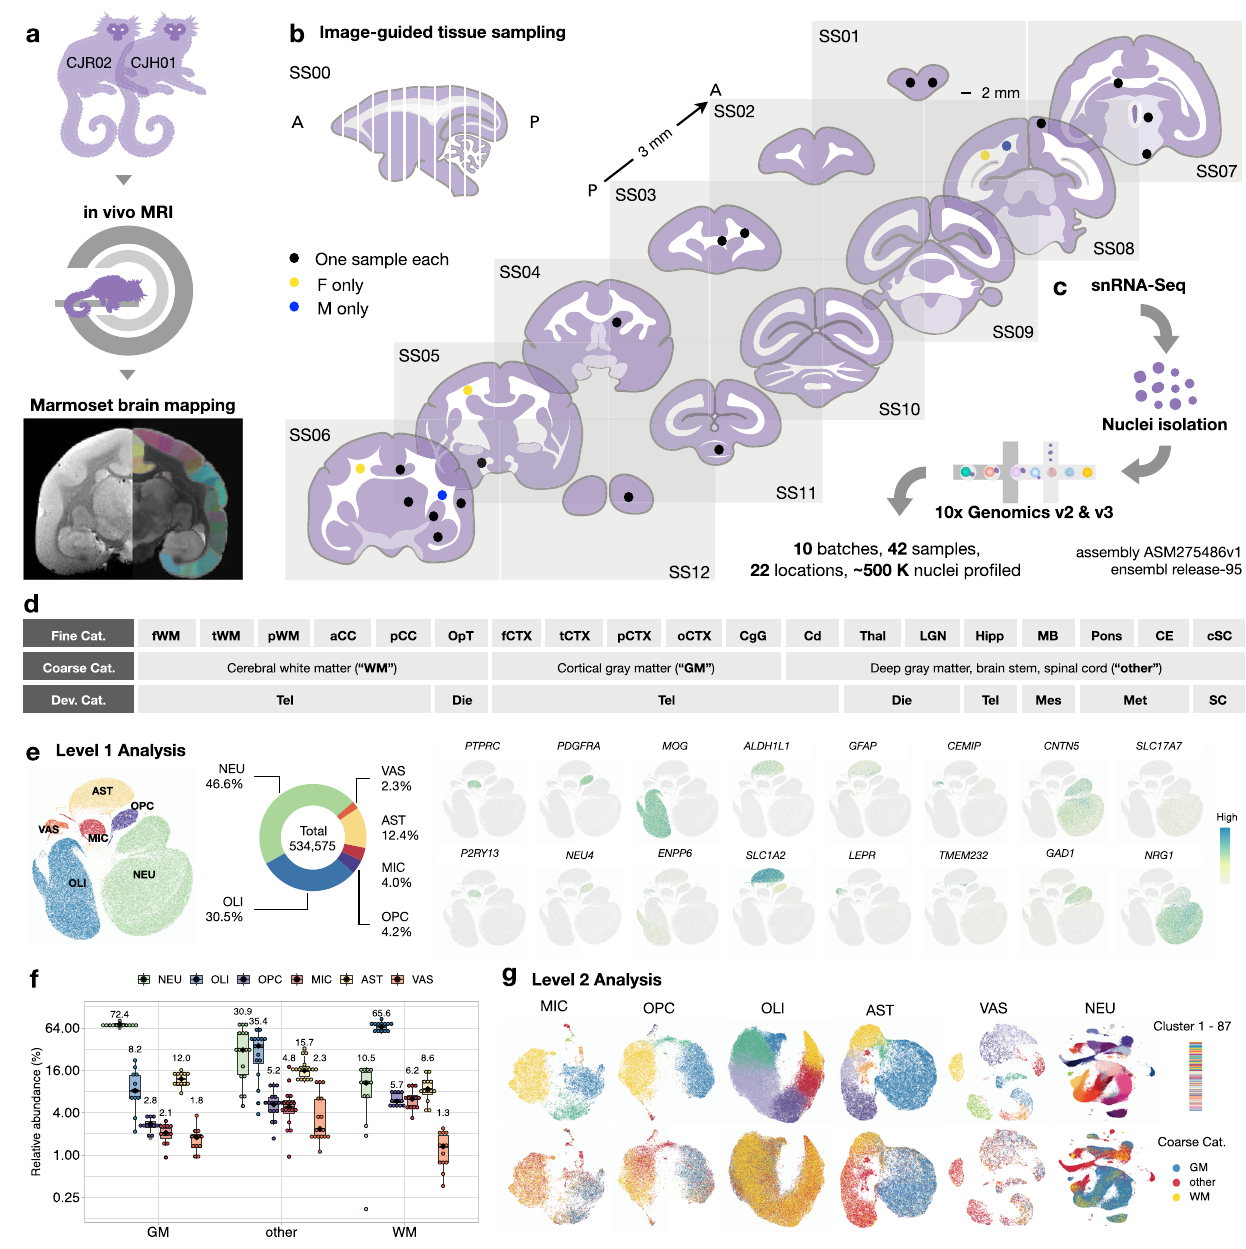
Fig. 1 | Glial transcriptome re fl ects differential residence in gray and white matter.a Experimentalwork fl owtoscanandmapimagestomarmosetMRIatlases. b Locationof samplescollectedascylindersof2mmdiameterand3mmthickness on the standard slab (SS) index. A anterior, P posterior. c Nuclei were isolated to prepare cDNA libraries and sequenced. d Total sampled areas are labeled by three types of tissue categories (Cat.): fi ne, coarse, and developmental (Dev). f frontal, t temporal,pparietal,WMwhitematter,aanterior,pposterior,CCcorpuscallosum, OpT optic tract, CTX cortex, o occipital, CgG cingulate gyrus, Cd caudate, Thal